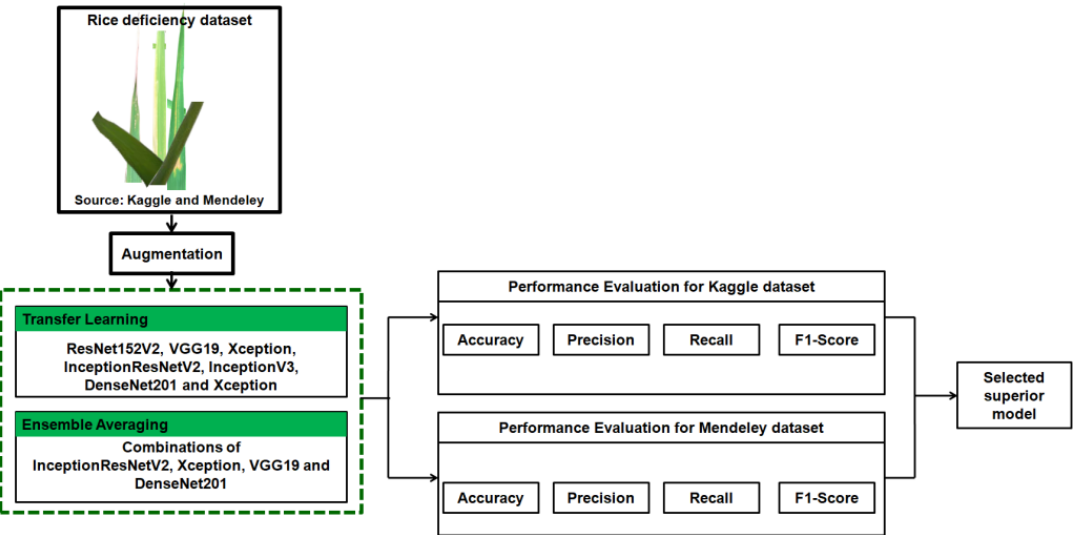
Figure 5. The proposed rice deficiency identification system.